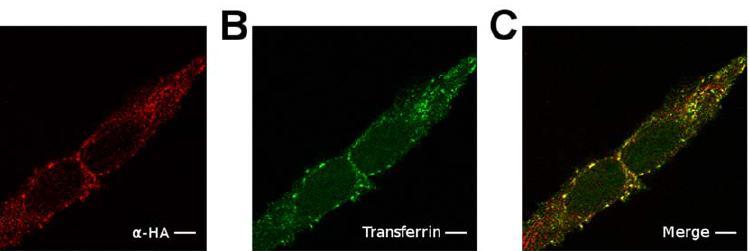
Figure 3. The transduction of Max* colocalizes with the internalized Transferrin. Confocal photomicrographs of HeLa cells simultaneously incubated with Max*HA and Transferrin- AF488 for 30 minutes. A) Immumofluorescence labeling of Max*HA, B) Fluorescence of Transferrin- AF488 and C) Merge. Scale bar=10 m m.